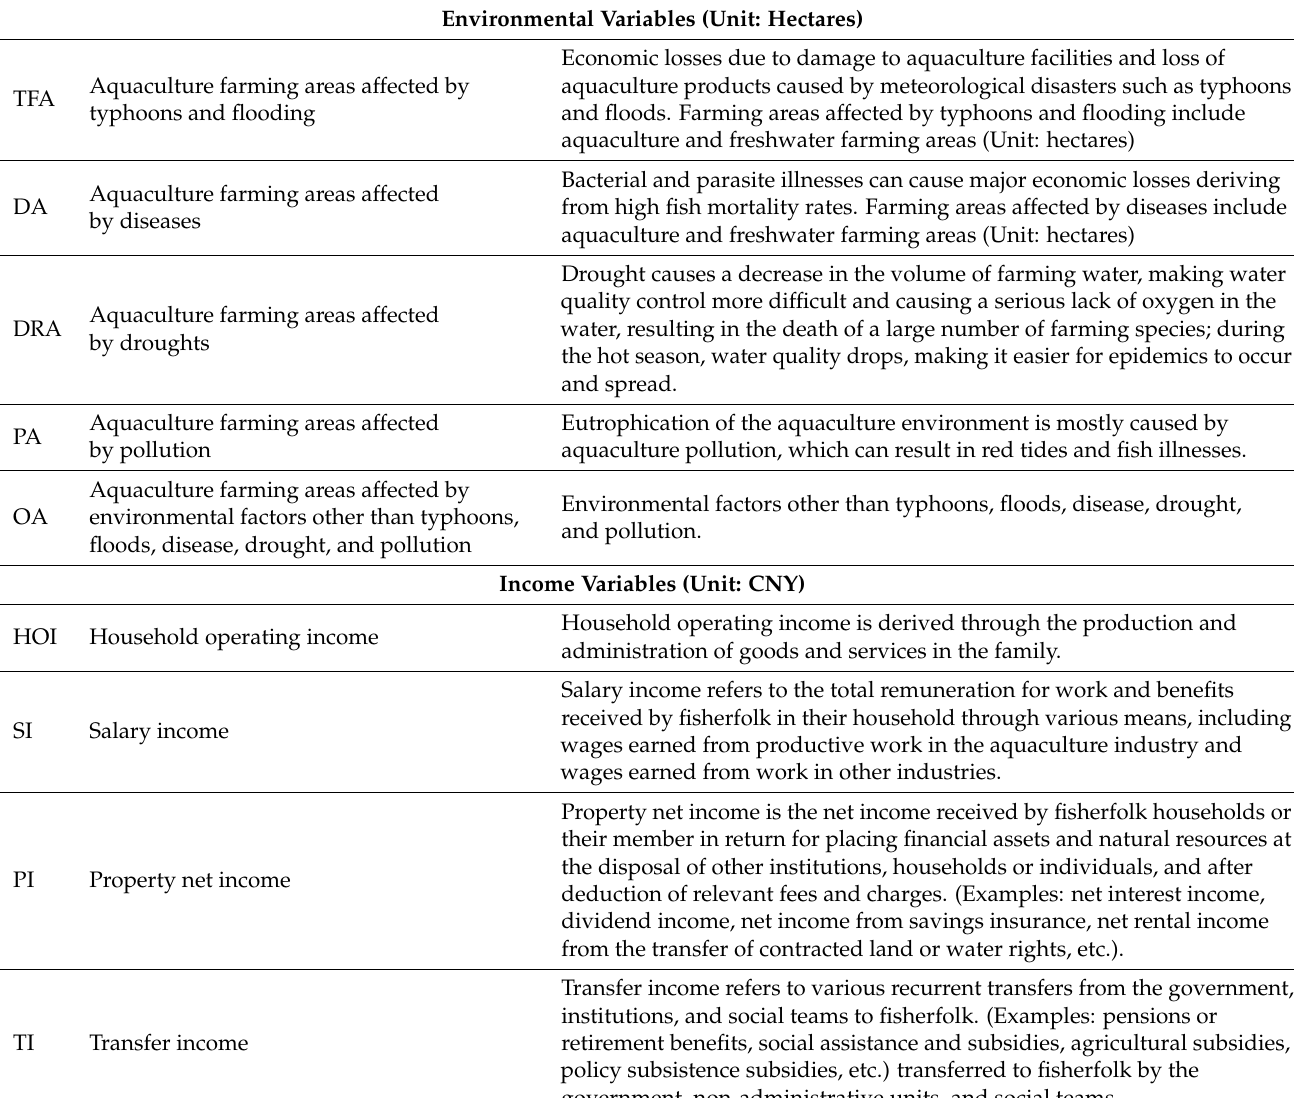
Table 1. Environmental variables affecting aquaculture production in China and the income variables of Chinese